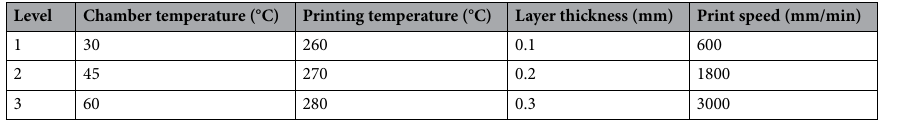
Table 2. The process parameters and their